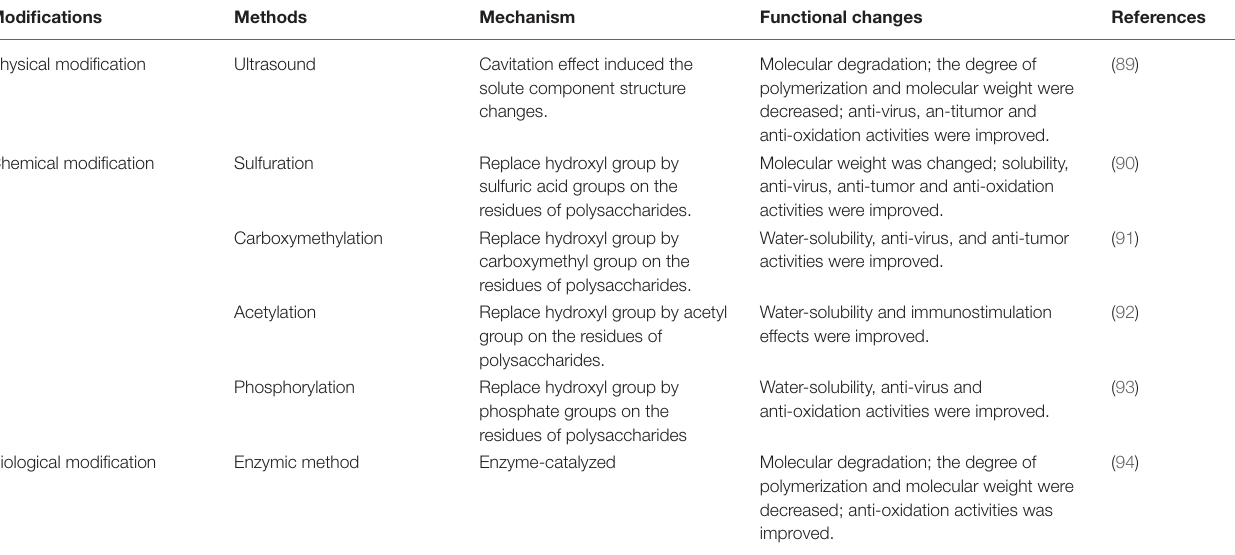
TABLE 4 | The different modifications of polysaccharides.